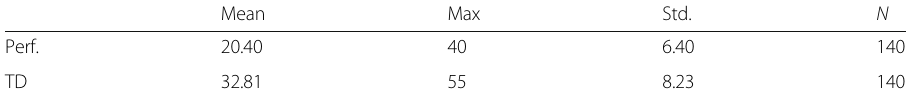
Table 2 Descriptive statistics for performance on the test and target domain of language use in the TOEFL iBT test Mean Max Std. N